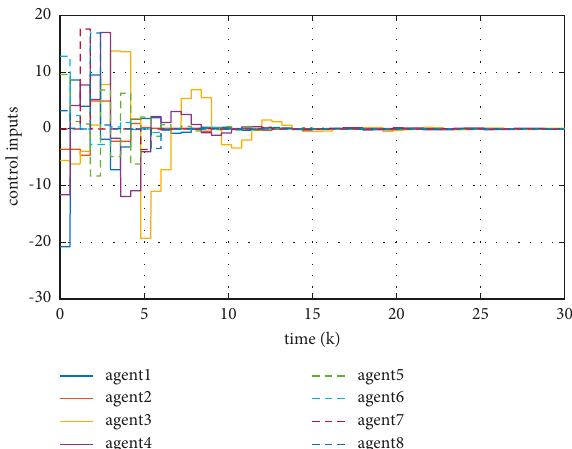
Figure 4: Control inputs of the dynamic agents.